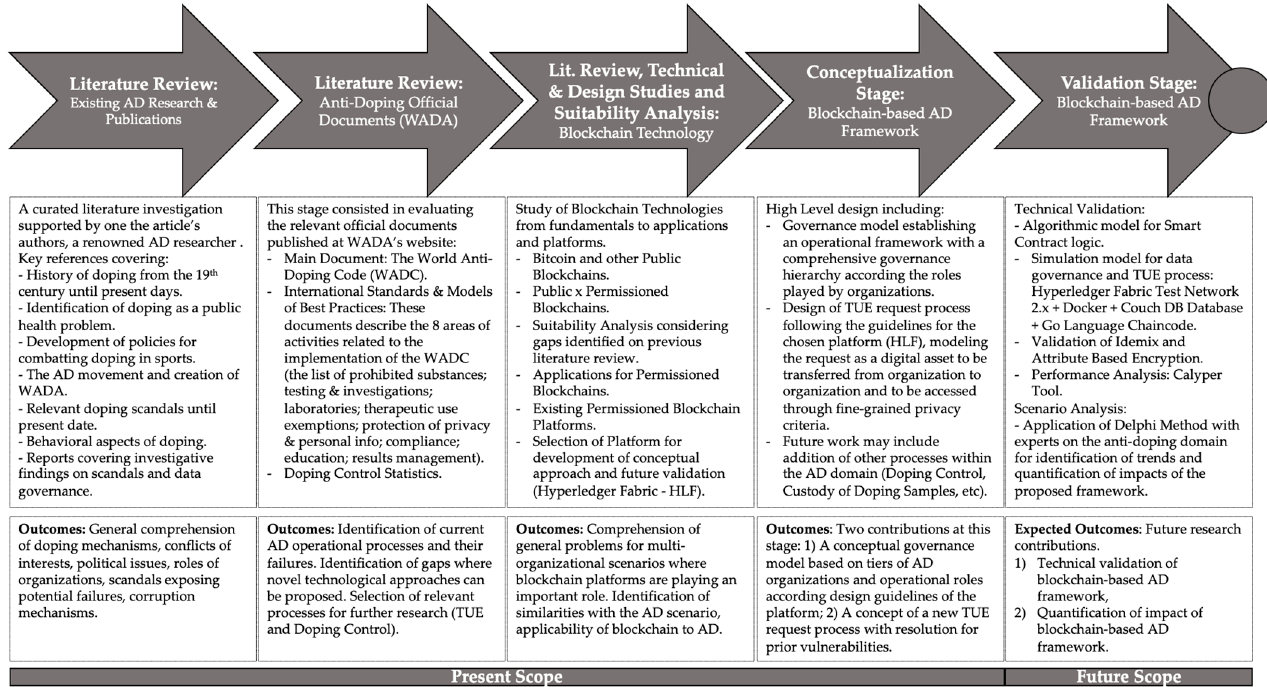
Figure 2. Research strategy workflow.